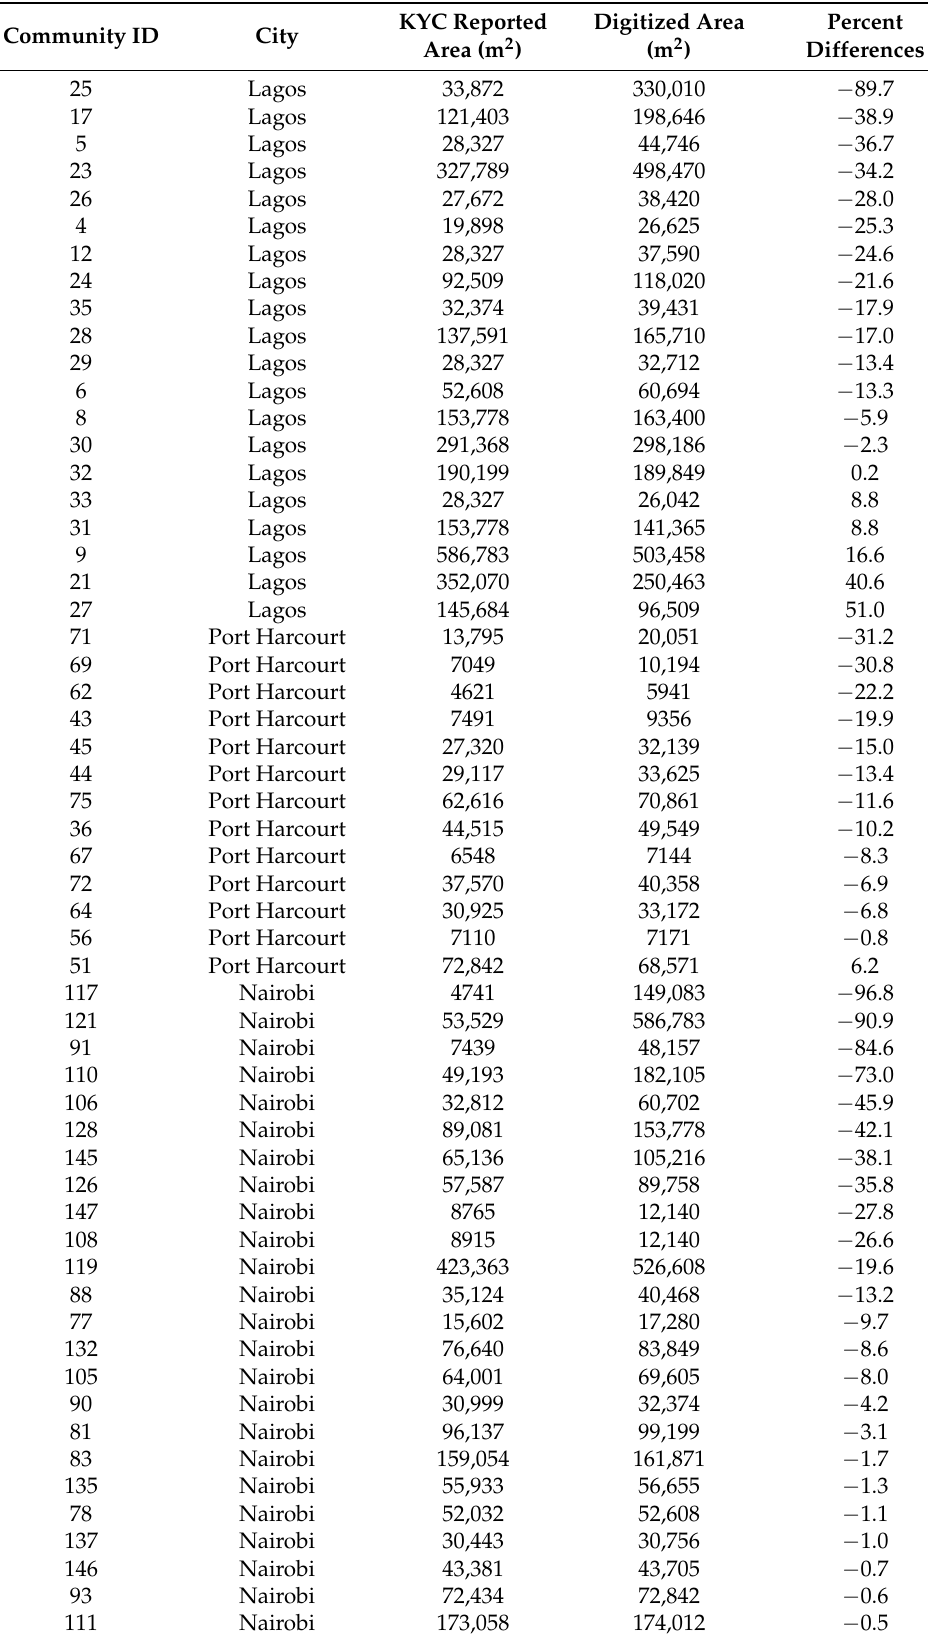
Table A1. Reported versus digitized boundary area for settlements in which area was reported. Community